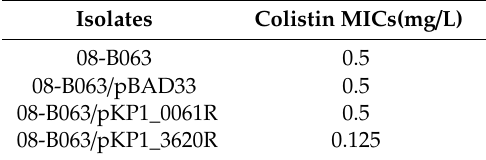
Table 3. Colistin MICs in 08-B063 strain harboring a pBAD33 vector containing altered